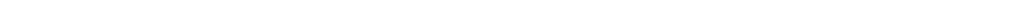
* p < 0.05 and ** p < 0.01, two-tailed Student ’ s t -test). f DKK1 transcriptional effect in control, A-ROD siRNA and intronic-ASO3 treated cells, assayed by extracting the ratio of 5 ′ to 3 ′ P-Ser2 Pol II ChIP signal depicted in ( e